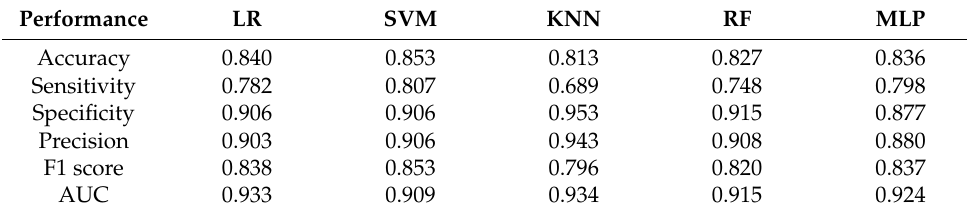
Figure 6. The ROC curves and AUC values of classifier models: ( a ) LR, ( b ) SVM, ( c ) KNN, ( d ) RF, ( e ) MLP. Table 5. Performances of prediction models with the different